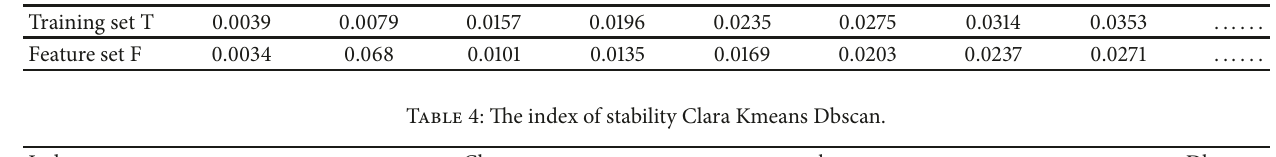
Table 3: Elliptical Fourier Description on the edge of fault classification.